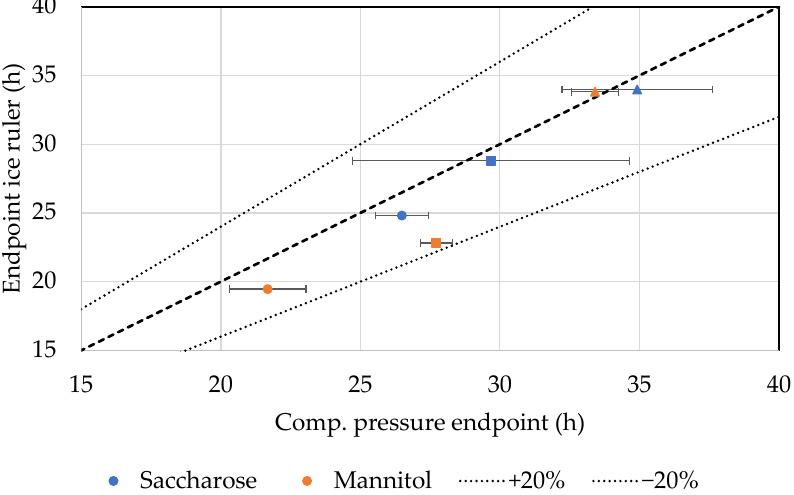
Figure 23. Primary drying endpoint of ice ruler and comparative pressure measurements (round — 5 g/L, square — 25 g/L, and triangle — 100 g/L).